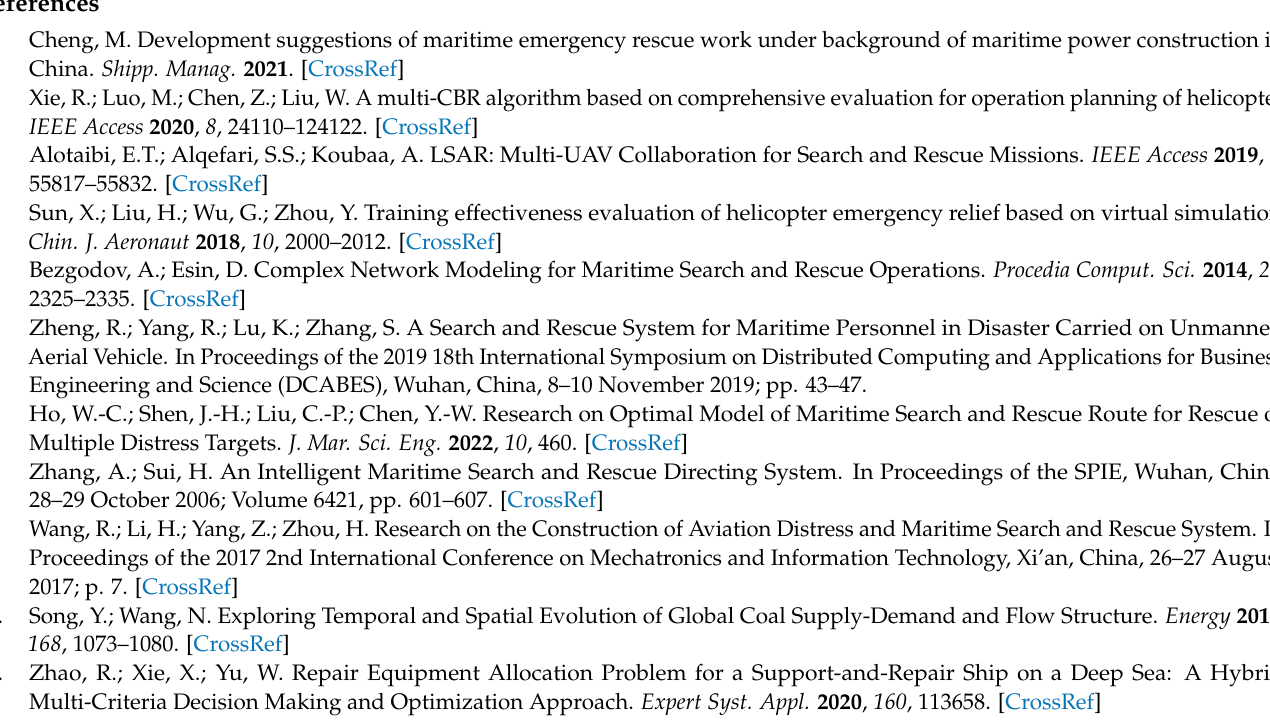
Figure A1. The pseudo code of k-means*.